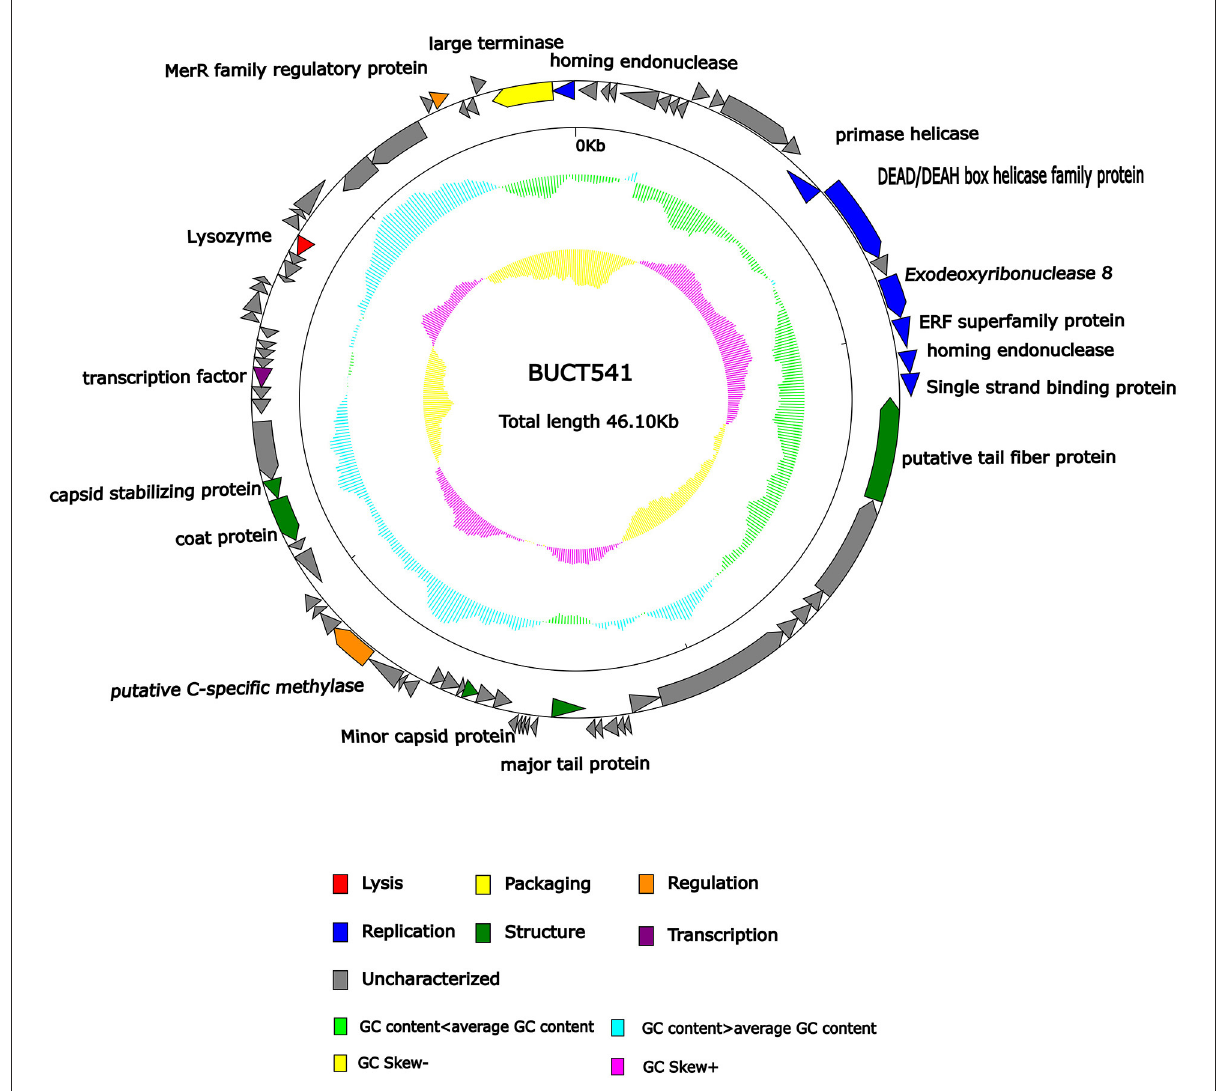
FIGURE3 Genomic map of bacteriophage BUCT541 and its genetic characteristics. Open reading frames (ORFs) are represented in different colors according to their functional categories.